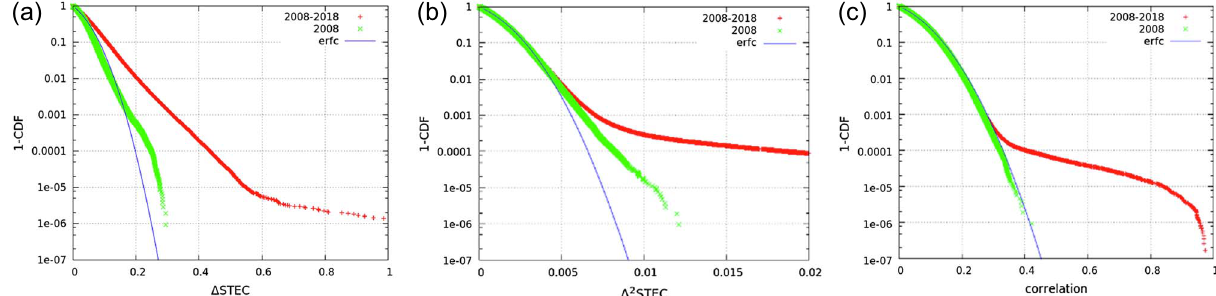
Fig. 9. Complementary of distribution functions for (a) D STEC, (b) D 2 STEC and (c) the correlation coef fi cient of the D